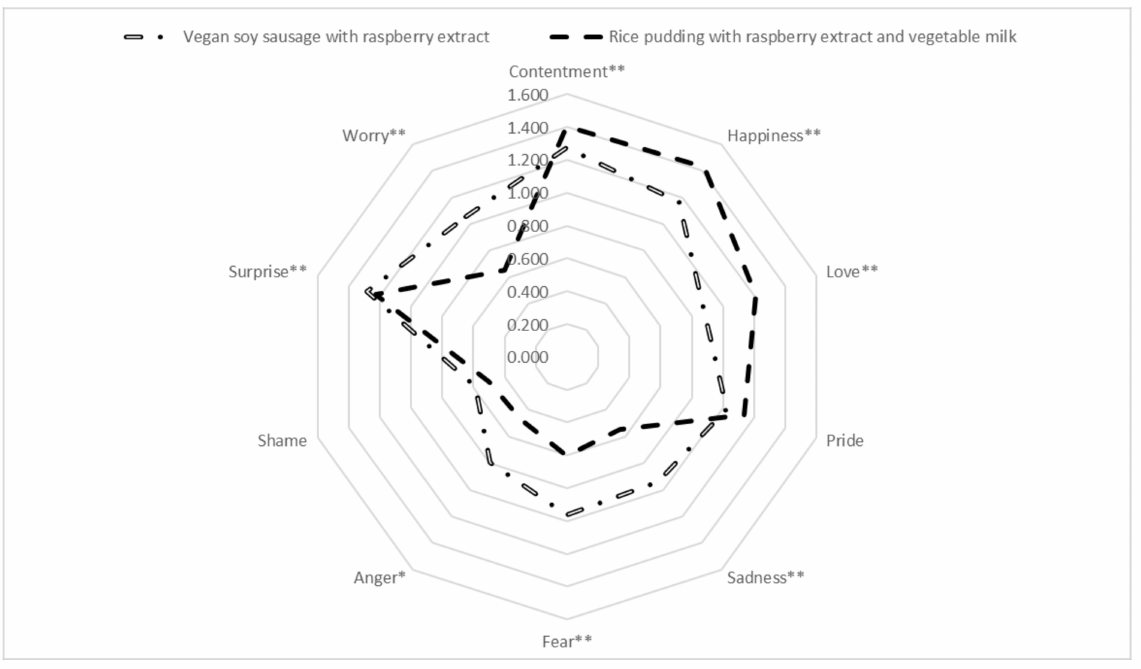
Figure 5. Radar chart of emotions felt while reading about the two product ideas. Emotions marked with * showed differences significant at 0.05 level; those marked with ** showed differences significant at 0.01